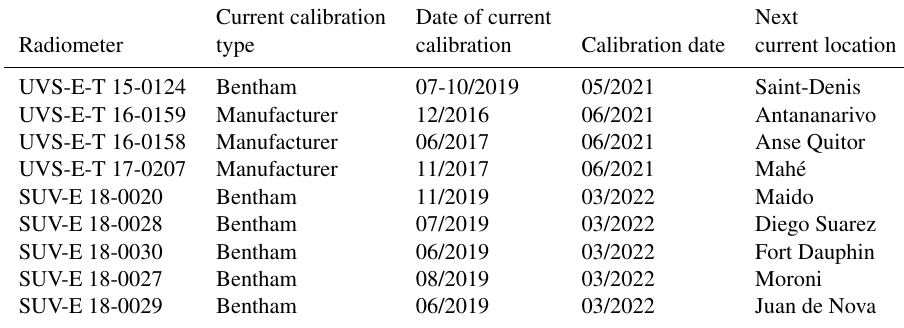
Table 3. Radiometers of the UV-Indien